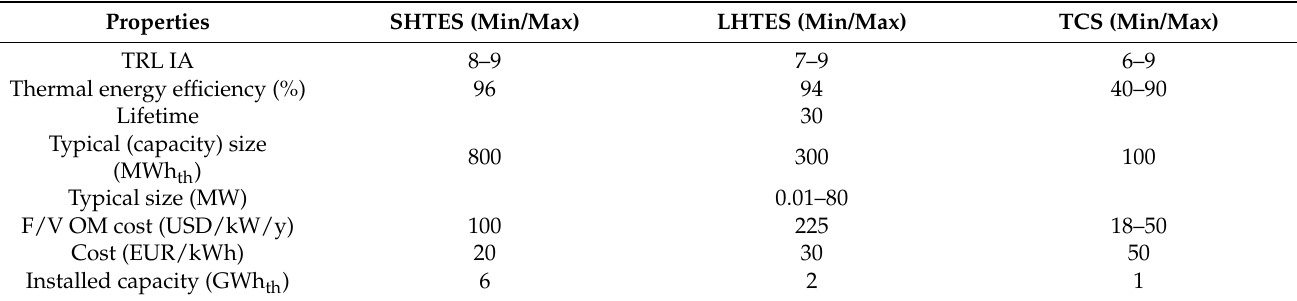
Table 9. Data projections between 2020 and 2030